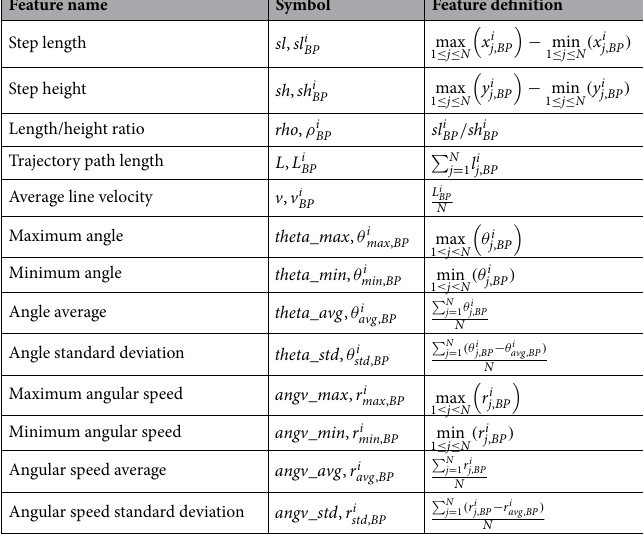
Table 1. Kinematic measurements and their definitions . Kinematic measurements were extracted bilaterally for all observed joints, except that the angular features of the foot and wrist were not extracted since the angular relations of these anatomical parts to the next distal limb elements are not easily measured and not easily related to locomotion. The variable N represents the number of data points sampled in this study and equaled